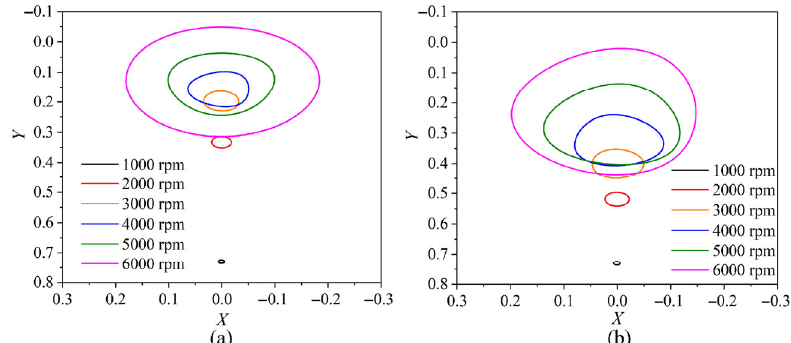
Fig. 8 Disk center orbits (a) with and (b) without turbulent and thermal